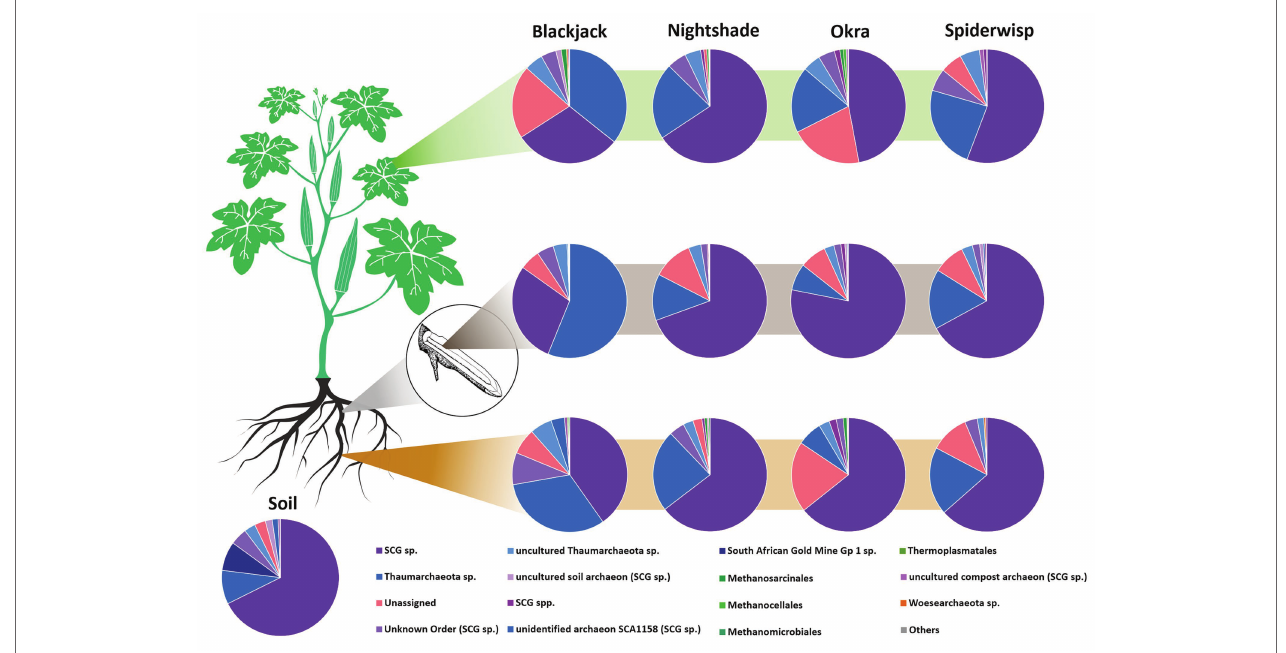
FIGURE 2 | Archaeal community in leafy greens. The composition of the archaeal community of blackjack, nightshade, okra and spiderwisp, and their microhabitats, displayed at the order level: phyllosphere (green stripe), root-endosphere (gray stripe), and rhizosphere (brown